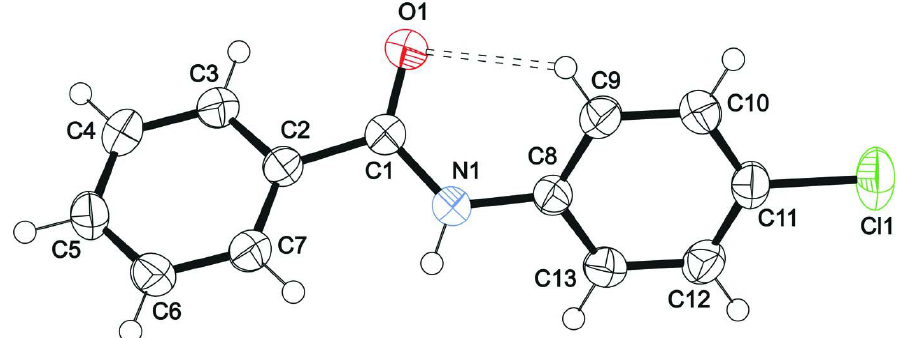
Molecular structure of the title compound showing the atom labelling scheme. Displacement ellipsoids are drawn at the 50% probability level. H atoms are represented as small spheres of arbitrary radii. Intramolecular hydrogen bond C9— H9···O1 is shown by dashed